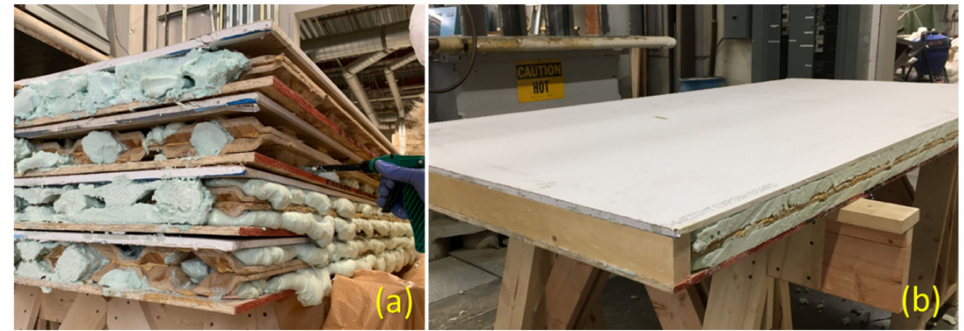
Figure 4. ( a ) Filling two-layered core sandwich panels with spray foam ( b ) trimmed foam and